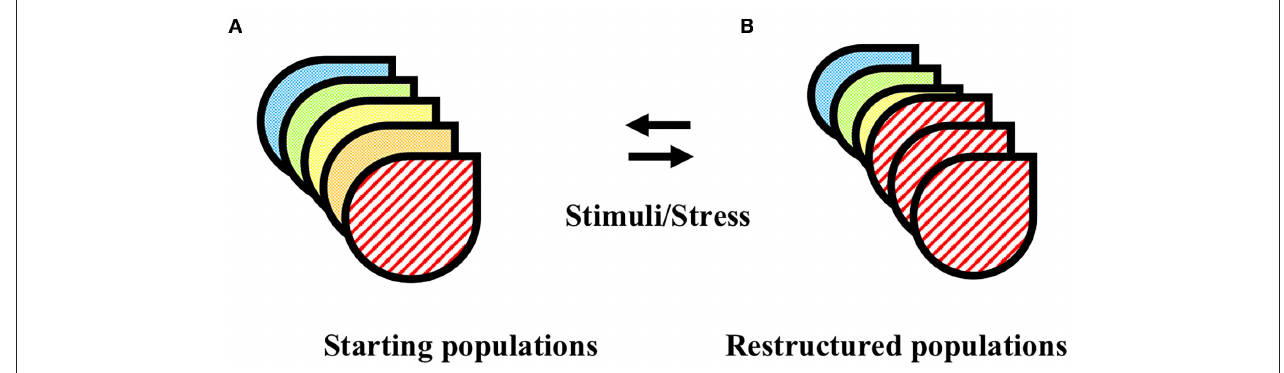
FIGURE 1 | Pituitary cell populations are restructured in response to physiological stimuli and pathological stressors. (A) The pituitary is comprised of multiple distinct functional cell types (designated by different image fill patterns). (B) In response to physiological stimuli or pathological stress, the pituitary cell populations undergo restructuring. The double arrows imply the potential reversibility of this process. See text for details and relevant